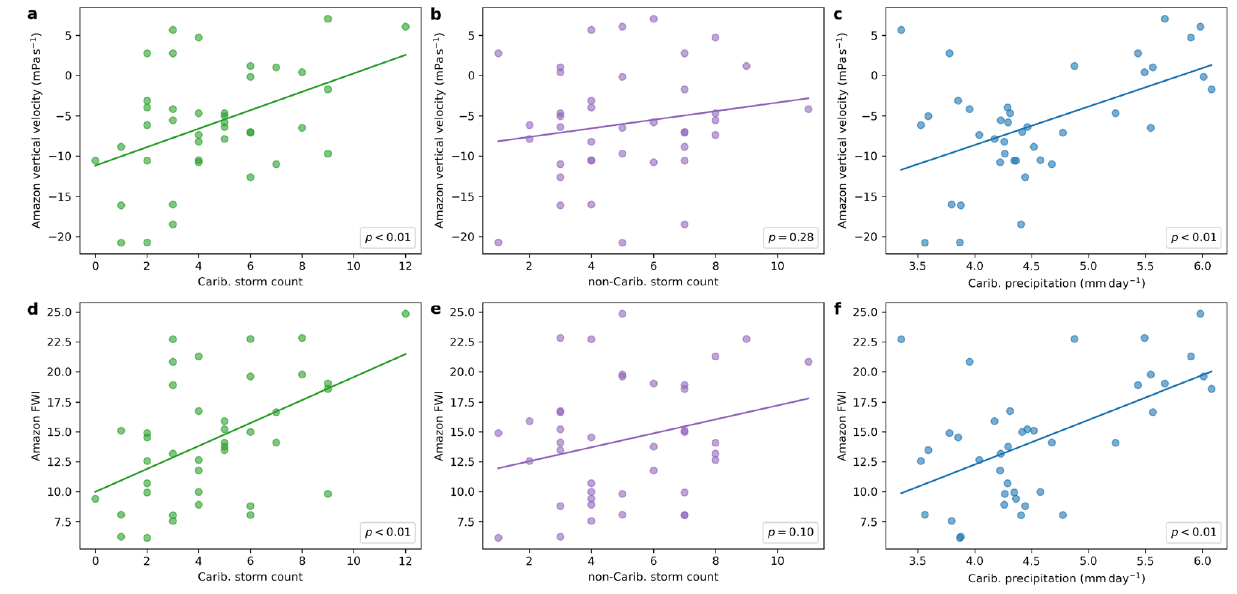
Figure 5. Relationship between the Amazon and the Caribbean. ( a ): Scatter plot with linear best fit of ASO Amazon vertical velocity at 600 hPa against ASO Caribbean tropical storm count computed from 1980 to 2019. ( b ): Same as ( a ) except for non-Caribbean tropical storm count. ( c ): Same as ( a ) except for Caribbean precipitation. ( d )–( f ): Same as ( a )–( c ) except for Amazon FWI.